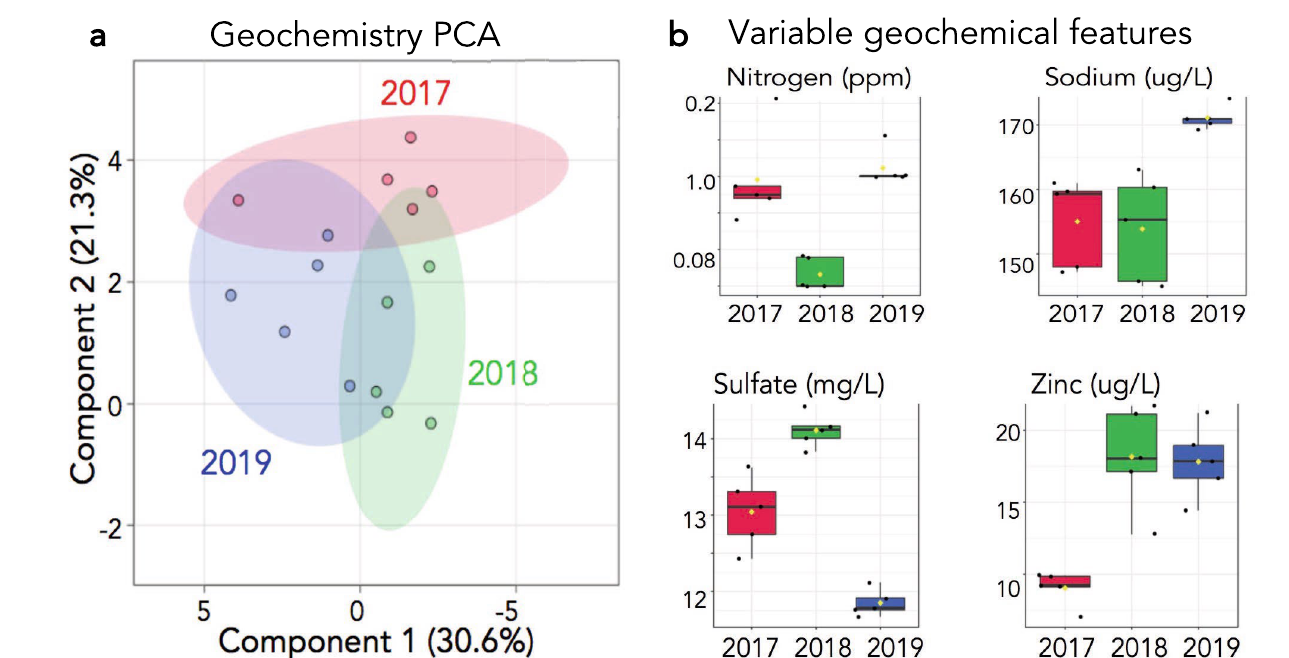
Figure 4. A geochemical analysis was completed at each sampling event. ( a ) 2D-PCA scores plot of all five springs by year. Shaded regions indicate 95% confidence intervals. ( b ) One-way parametric ANOVA analysis indicating geochemical features whose levels are significantly different (p-value < 0.05) between the three